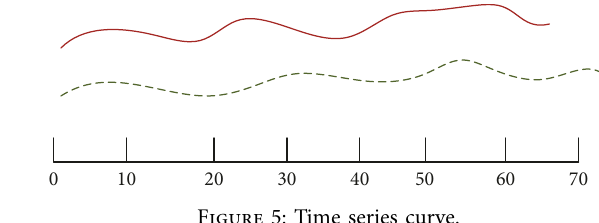
Figure 5: Time series curve.